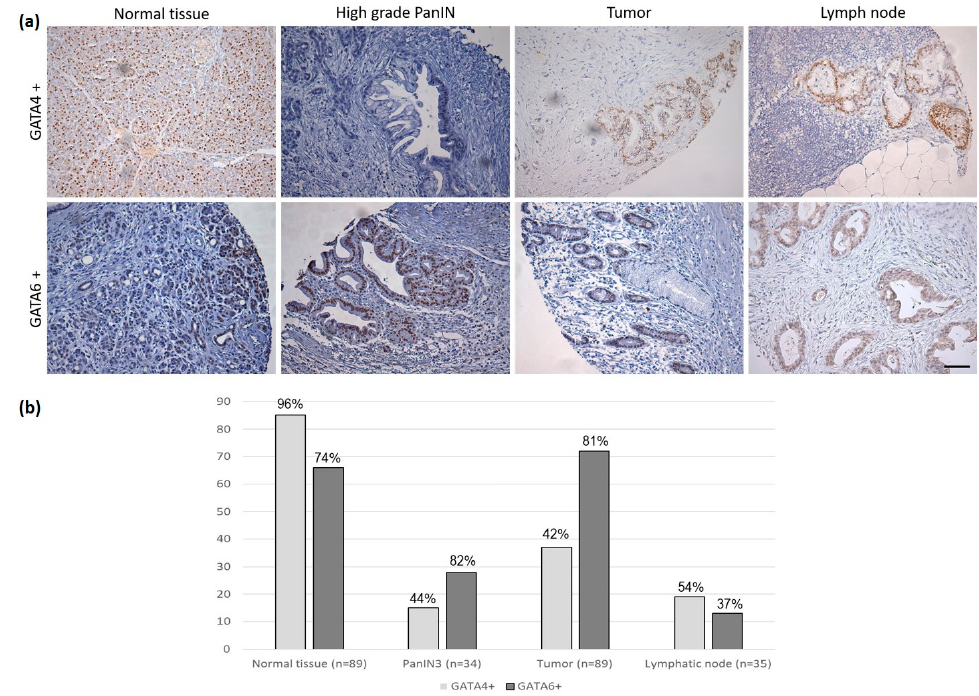
Figure 1. GATA4 and GATA6 expression in normal tissue, PanIN, tumor tissue and lymph node metastasis: ( a ) GATA4+ (upper panel) and GATA6+ (lower panel) immunohistochemistry images. Scale bar represents 100 µm; ( b ) Graphical representation of GATA4+ and GATA6+ distribution.